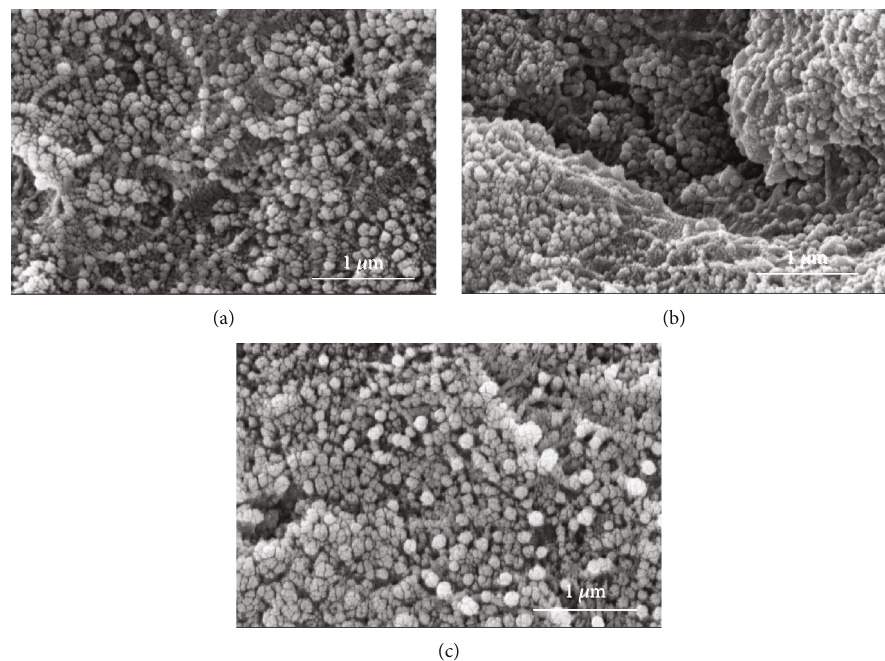
Figure 6: SEM micrographs of the BT/PVDF composites: (a) BT10/PVDF; (b) BT15/PVDF; (c) BT20/PVDF.